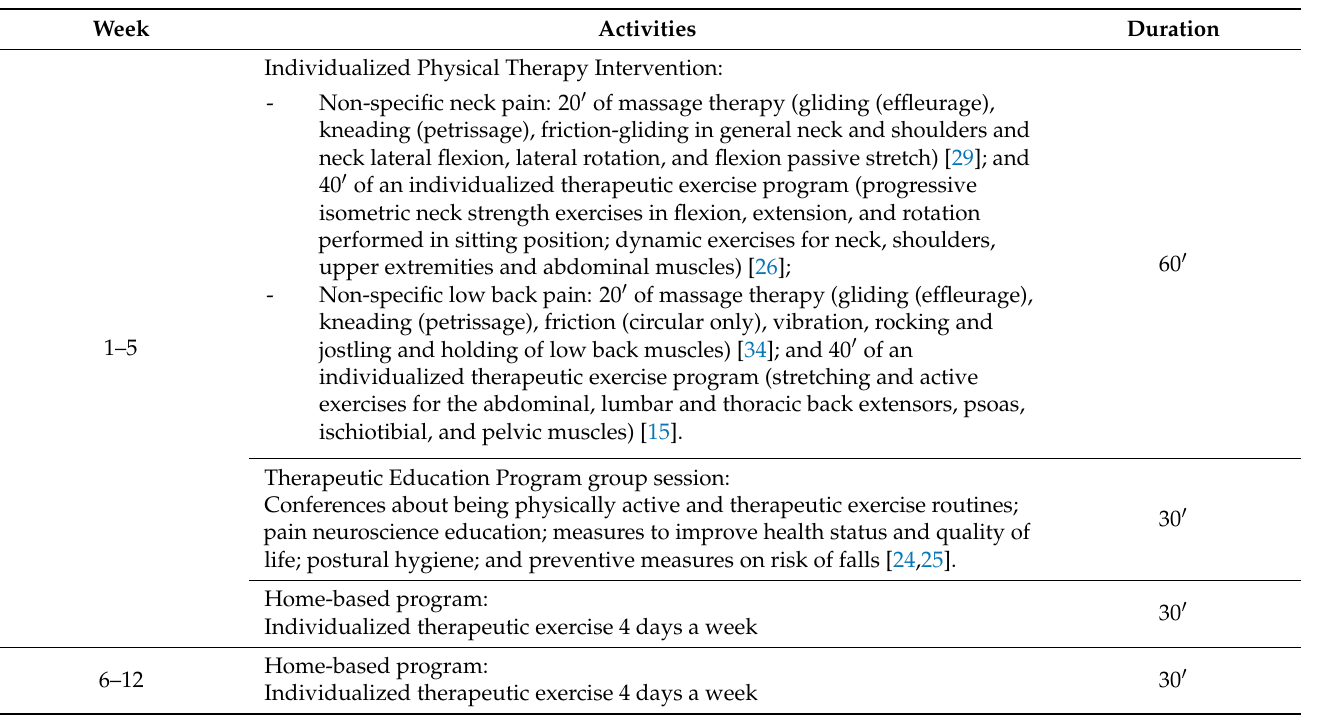
Table 1. Geriatric Physical Therapy Group intervention.